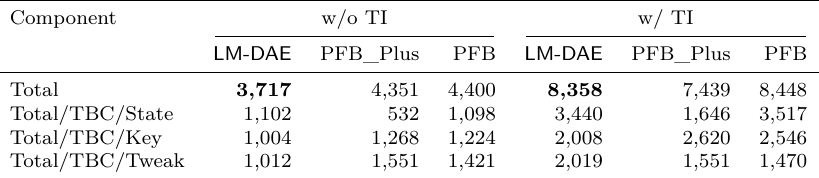
Figure 16: Datapath diagram of LM-DAE instantiated with TweSKINNY. Table 4: Circuit area breakdown of LM-DAE [TweSKINNY-128-256], PFB_Plus[SKINNYe- 64-256], and PFB[SKINNY-128-256]. The PFB_Plus and PFB performances are based on Table 4 of